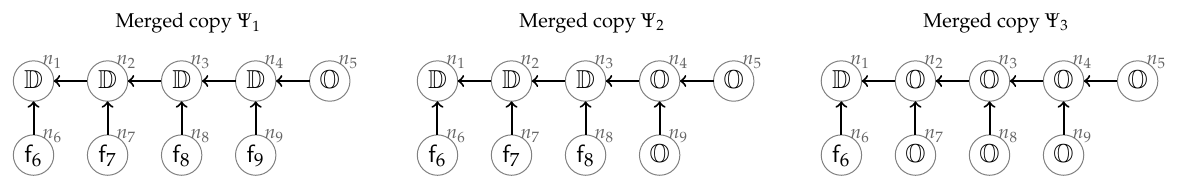
Figure 4. Three possible results of synchronizing the filesystems in Figure